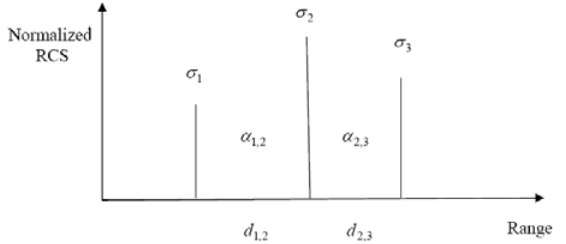
Figure 9. Scattering centers of an extended target.